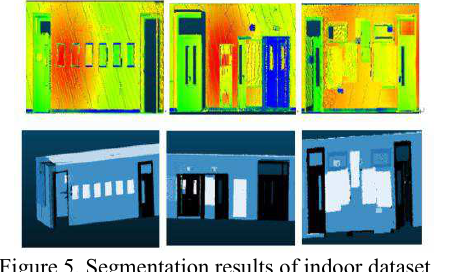
Figure 4. Segmentation Results of Area5 in S3DIS Dataset